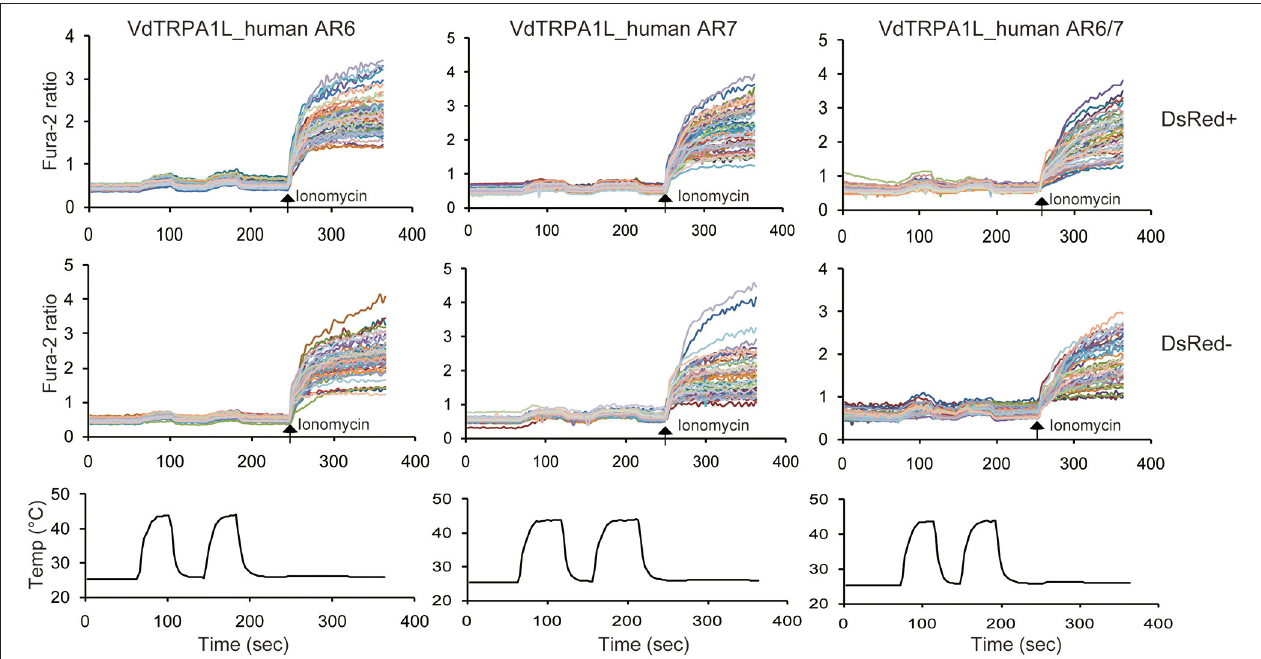
FIGURE 4 | Loss of heat-activation with the chimeric VdTRPA1L channels. Two upper traces indicate the changes of intracellular calcium level in transfected (DsRed + ) and non-transfected (DsRed-) cells with three chimeric VdTRPA1L channels in which the AR6, AR7, or ARs 6 and 7 were replaced by the corresponding ARs of HsTRPA1 (VdTRPA1L_human AR6, VdTRPA1L_human AR7, and VdTRPA1L_human ARs6/7) as well as DsRed by heat. Each line represents the intracellular calcium level in the individual cell measured by calcium imaging. The arrows show the time points when 5 µ M ionomycin was added. The bottom traces show the changes of bath temperature by time (sec,